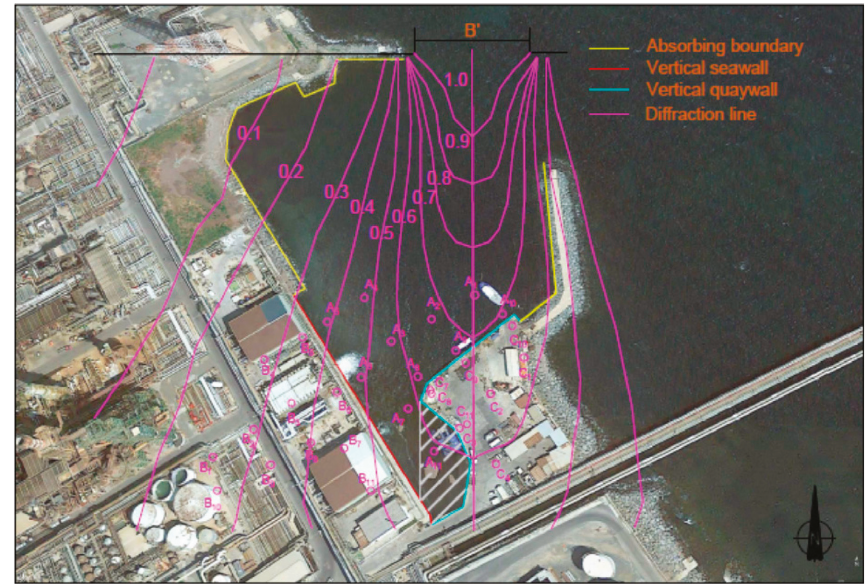
Figure 7: Mirror-imaged diffraction diagram at the Saras harbor considering a mean direction incident wave of 0 ° N. Table 3: Superimposition of diffracted and reflected wave heights (location points is shown in Figure 7). Ratio of superimposed wave Point Zone A Zone B Zone C